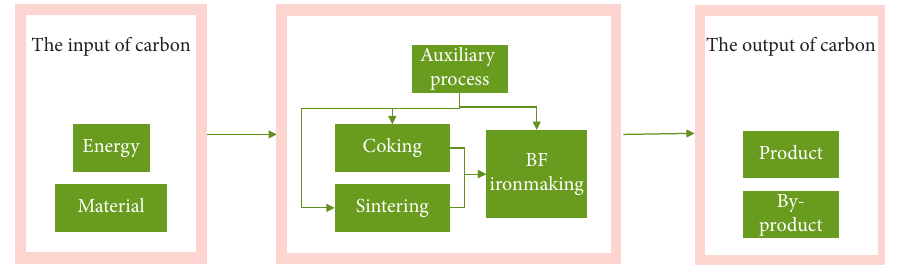
Figure 2: The boundary of the carbon emission model of the ironmaking system. Table 1: Exergoeconomic cost of the ironmaking system.